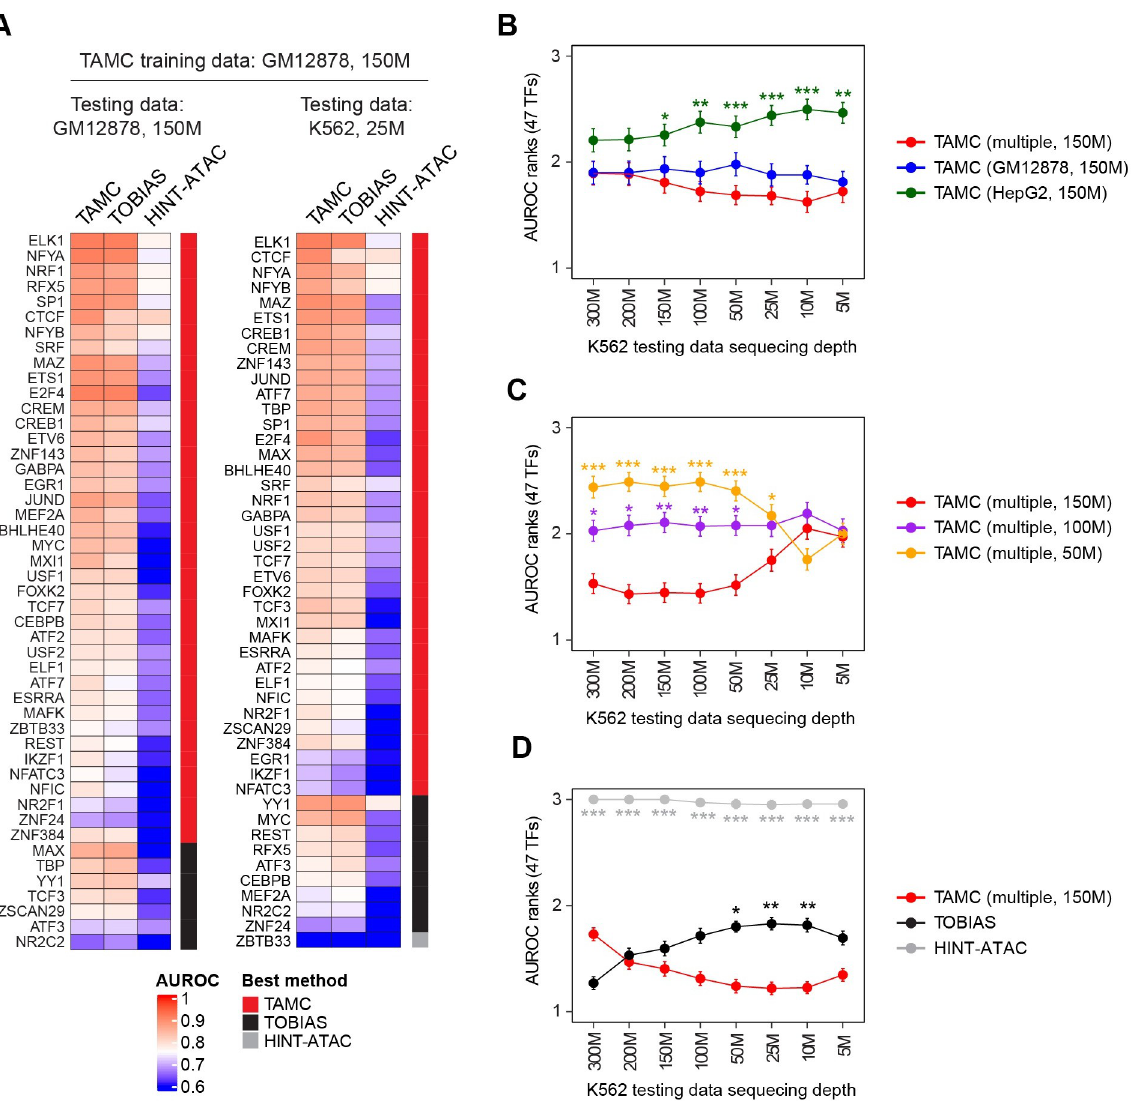
Fig 2. TAMC outperforms existed methods. (A) Heat maps compare intra-data (left) and cross-data (right) classification performance of TAMC with TOBIAS and HINT-ATAC. Test data are indicated above each heatmap, and TAMC models were trained using GM12878 ATAC- seq data with 150M sequencing depth in both heatmaps. (B) Line graph compares cross-data classification performance of TAMC models trained on ATAC-seq data of GM12878, HepG2 and multiple (GM12878 and HepG2) cell lines. (C) Line graph compares cross-data classification performance of TAMC models trained on multiple (GM12878 and HepG2) ATAC-seq data with 150M, 100M and 50M sequencing depth. (D) Line graph compares cross-data classification performance of TAMC (multiple, 150M) with TOBIAS and HINT-ATAC. The performance of models within each line graph were ranked from 1 to 3 for each TF. The higher AUROC is, the lower rank number is given. The points in the line graphs show the average AUROC ranks for 47 TFs for each method/model and the error bars represent standard error or mean (SEM). Difference between the performance of TAMC (multiple, 150M) and the other methods/models were examined using Friedman- Nemenyi test and significant differences are labeled ( � p < 0.05; �� p < 0.01; ��� p < 0.001). Complete statistic test results for B , C and D are provided in S3 Table. The cell type and sequencing depth of ATAC-seq data used for train TAMC models are indicated within the parenthesis. HINT-ATAC models pre-trained on GM128782 ATAC-seq data were used for all testing, while TOBIAS does not require model training before testing. M denotes million high-quality non-mitochondrial aligned